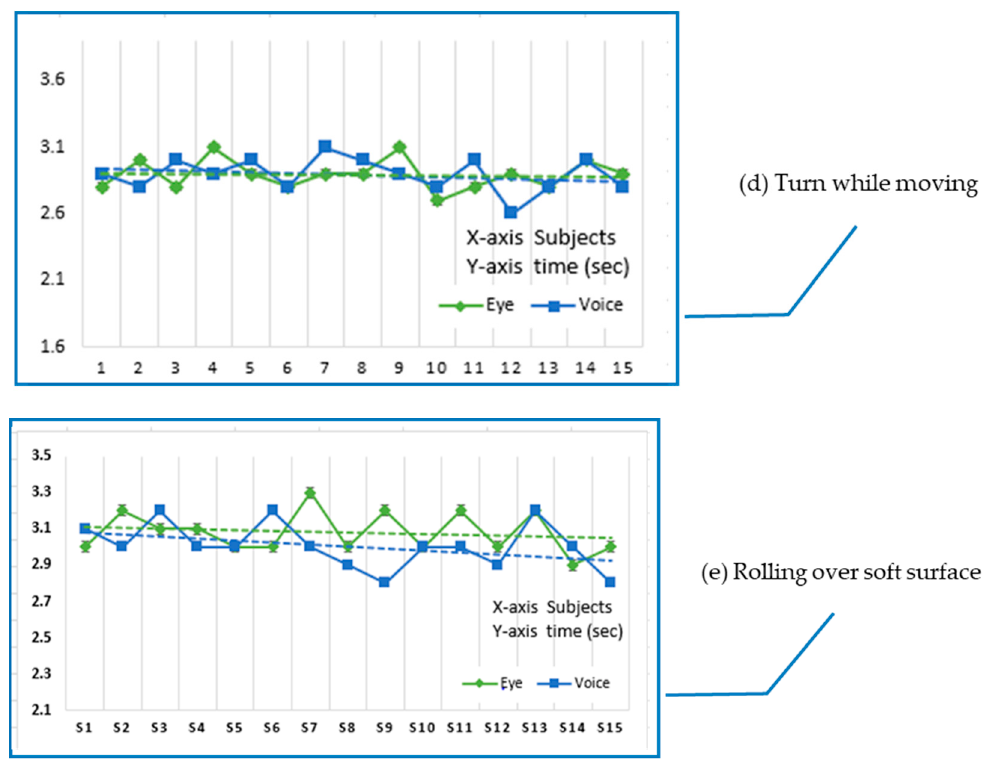
Figure 10. Graphical representation of a basic wheelchair skill test (WST). ( a ) Forward move on a plain surface. ( b ) Backward move over the plain surface. ( c ) Turn in place. ( d ) Turn while moving ( e ) Rolling over a soft surface.